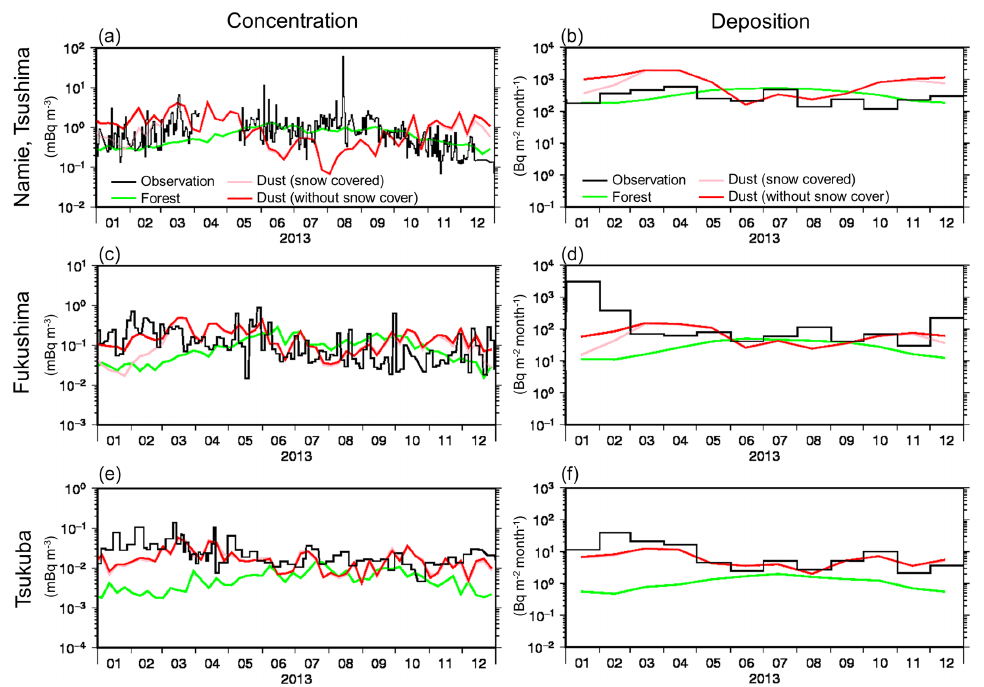
Figure 11. (a, c, e) Temporal variations in the surface concentrations of (black) observed 137 Cs and simulated 137 Cs associated with (red) dust aerosols (denoted as “1–10kBqm − 2 ” in Fig. 10), (pink) dust aerosols with emissions suppressed by surface snow coverage (denoted as “Snow cover” in Fig. 10), and (lime) forest aerosols (denoted as “1–10kBqm − 2 ” in Fig. 10), assuming supermicron sizes of 137 Cs-bearing particles at (top to bottom) Namie (Tsushima), Fukushima, and Tsukuba (mBqm − 3 ). The sampling intervals are used for the observations, but weekly mean values are depicted for the simulations. (b, d, f) Same as the left panels but for the monthly cumulative deposition amounts (Bqm − 2